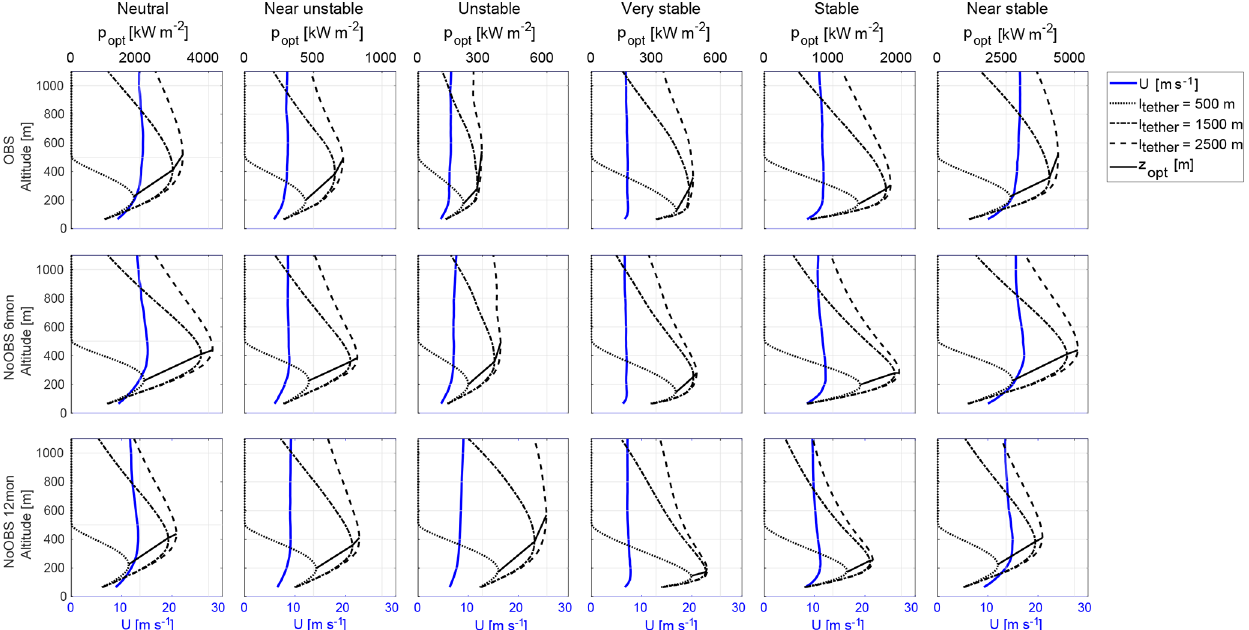
Figure 11. Optimal traction power per wing area p opt (dashed lines) and optimal operational altitude (solid line) estimated based on mean wind speed profiles categorized by Obukhov length ( L ) for 6-month OBS, 6-month NoOBS and 12-month NoOBS simulations with varying tether length ( l tether =